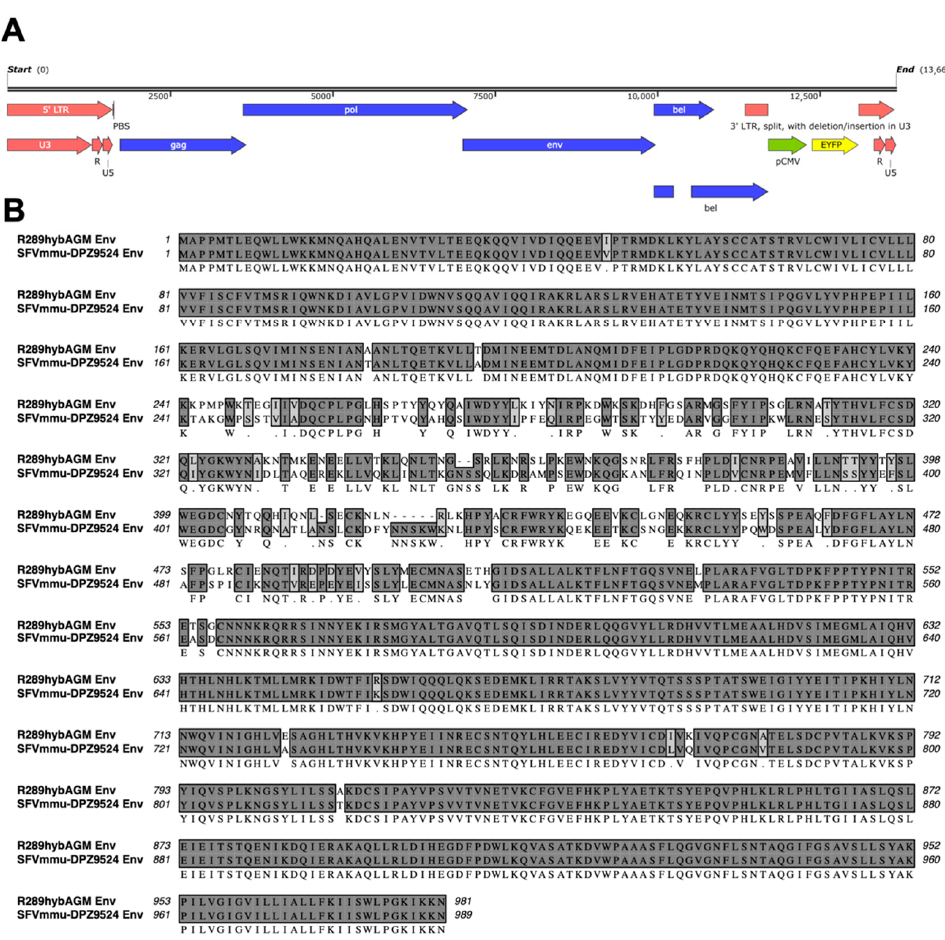
Figure 2. Generation and characterization of SFV reporter viruses with genotype 1 and geno- type 2 env . ( A ) Genome structure of the SFV YFP reporter viruses. The CMV immediate- early promoter (pCMV)-driven YFP (enhanced YFP, EYFP) expression cassette was inserted into the U3 region of the 3 (cid:48) LTR, thereby deleting 709 bp of the LTR. The envelope gene of SFVmmu_R289hybAGM was inserted into this construct in order to generate two otherwise isogenic YFP reporter gene foamy virus proviral clones, AX571 pSFVmmu-DPZ9524_1_CMVie-YFP (ST1) and AX585 pDPZ9524_1_R289hybAGMenv_CMVie-YFP (ST2). The unspliced bel transcript designates the Tas mRNA, the spliced bel transcript designates the Bet mRNA. ( B ) Sequence alignment of the Env proteins of ST1 and